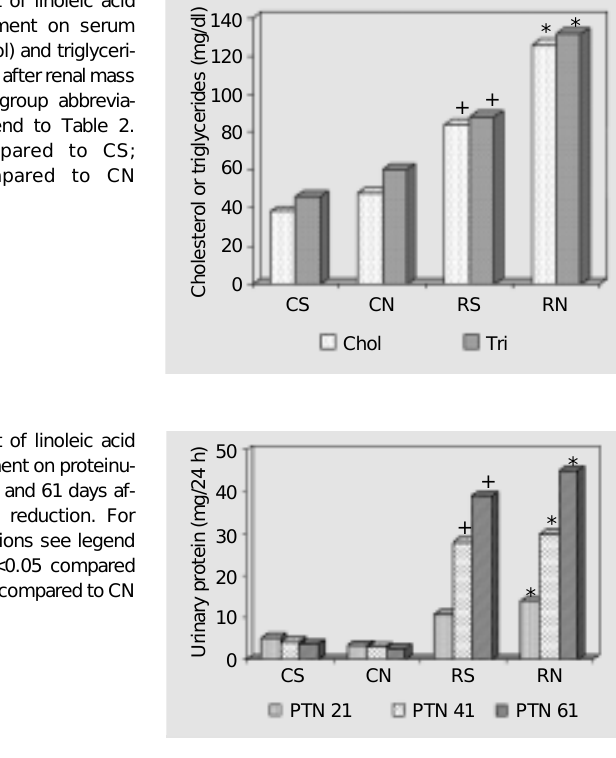
Table 2. Effect of linoleic acid dietary supplement on kidney morphology after mass reduction.